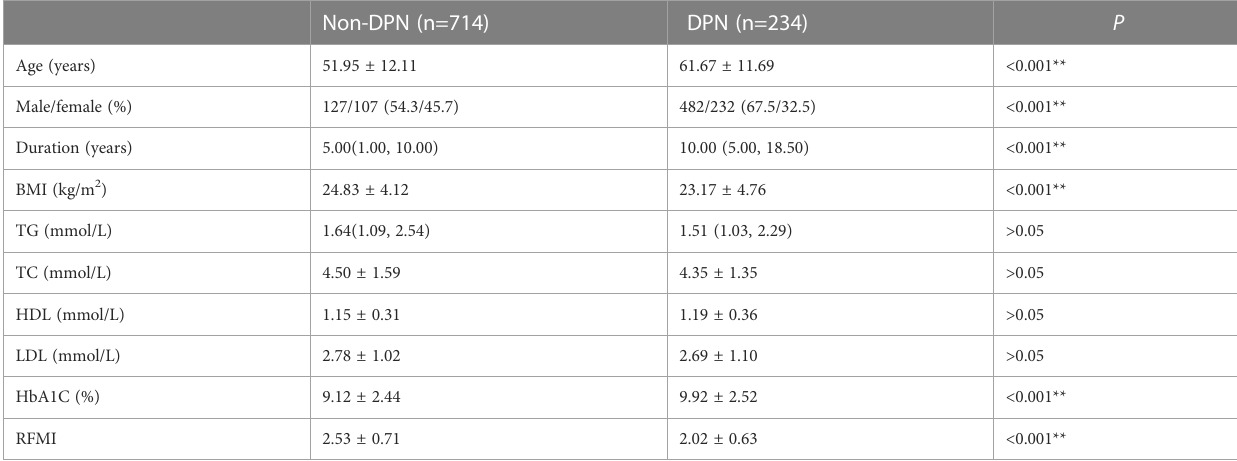
TABLE 1 Clinical characteristics of T2DM patients with DPN versus without